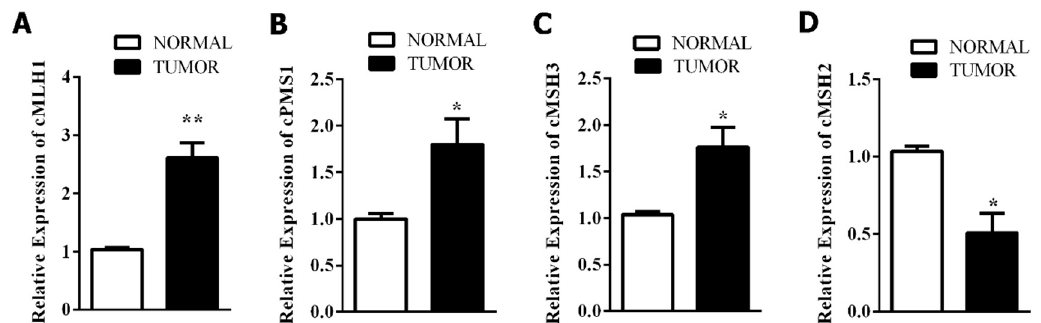
Figure 4. Expression of genes cMLH1 ( A ), cPMS1 ( B ), cMSH3 ( C ), cMSH2 ( D ) in normal and tumor canine mammary tissues (* p < 0.05,** p < 0.01).